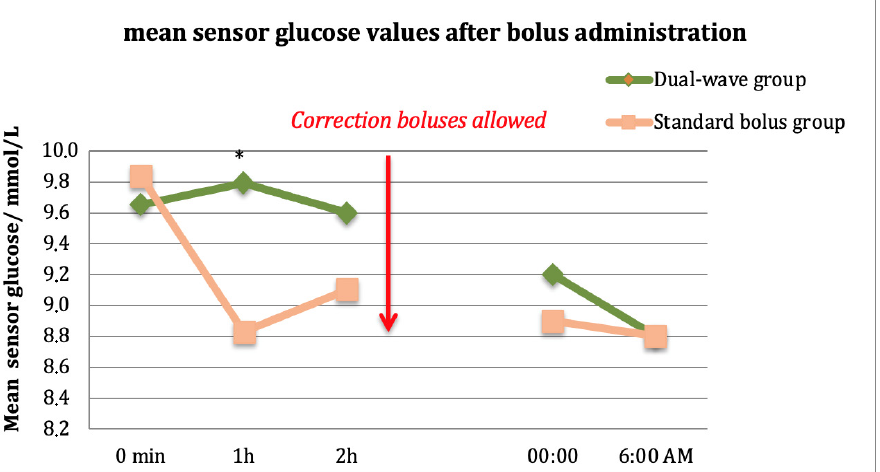
Figure 3. Comparison of mean sensor glucose values after main evening meal bolus administration between treatment arms. * Statistically relevant difference in sensor glucose between treatment arms, p = 0.01.